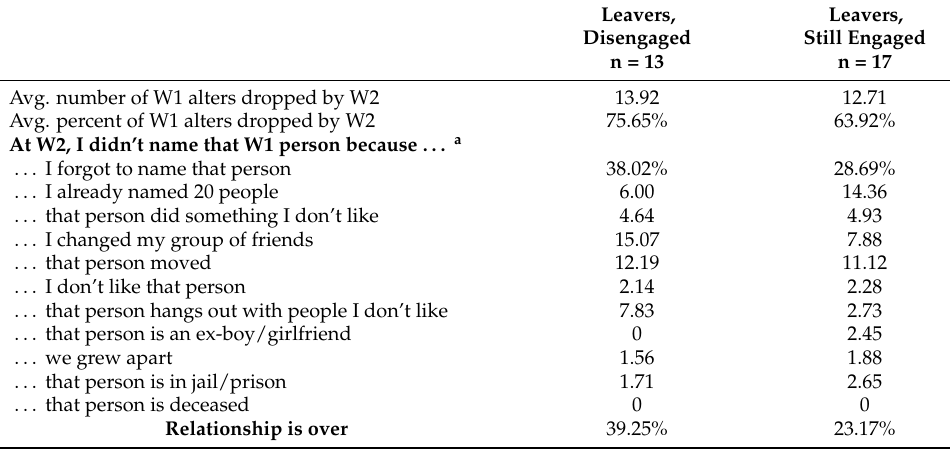
Table 7. Reasons Why Respondents’ Dropped Alters at Wave 2, Group-leavers, Disengaged versus Engaged, Averaged Across Ego Networks.